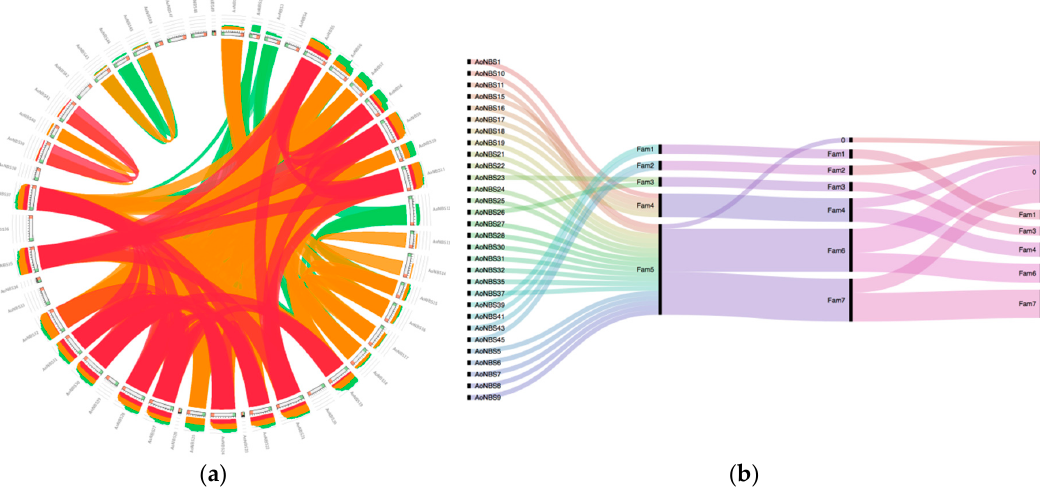
Figure 3. Gene duplications. ( a ) Similarity of NBS genes. Red color shows the highest similarity (>99% identity), followed by orange (95–99%) and green (90–95%) colors. ( b ) Alluvial diagram of the organization in NBS gene families across 70–80–90% similarities/coverage thresholds.